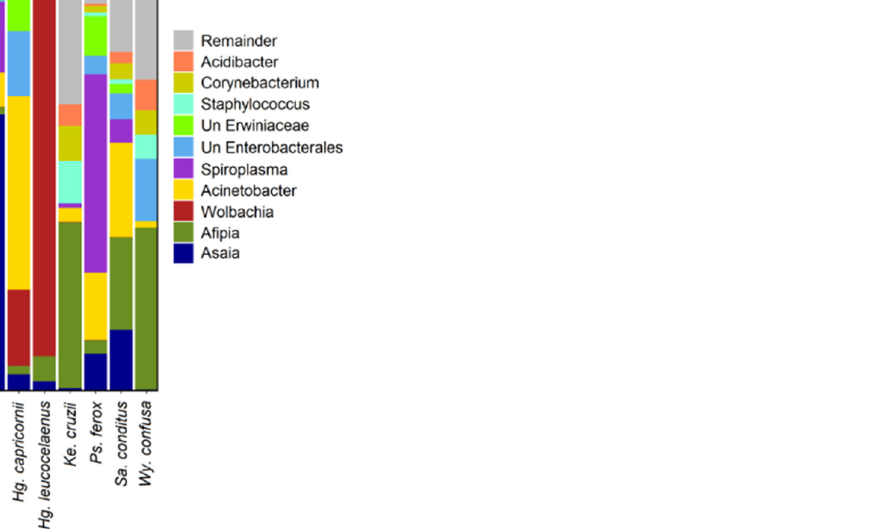
Figure 2. Bar graph depicting the bacterial amplicon sequence variants (ASV) composition at the bottom taxonomic level (genus) for each mosquito species. Remainder (gray bars) corresponds to genera that had 2% or less of the total contigs analyzed.